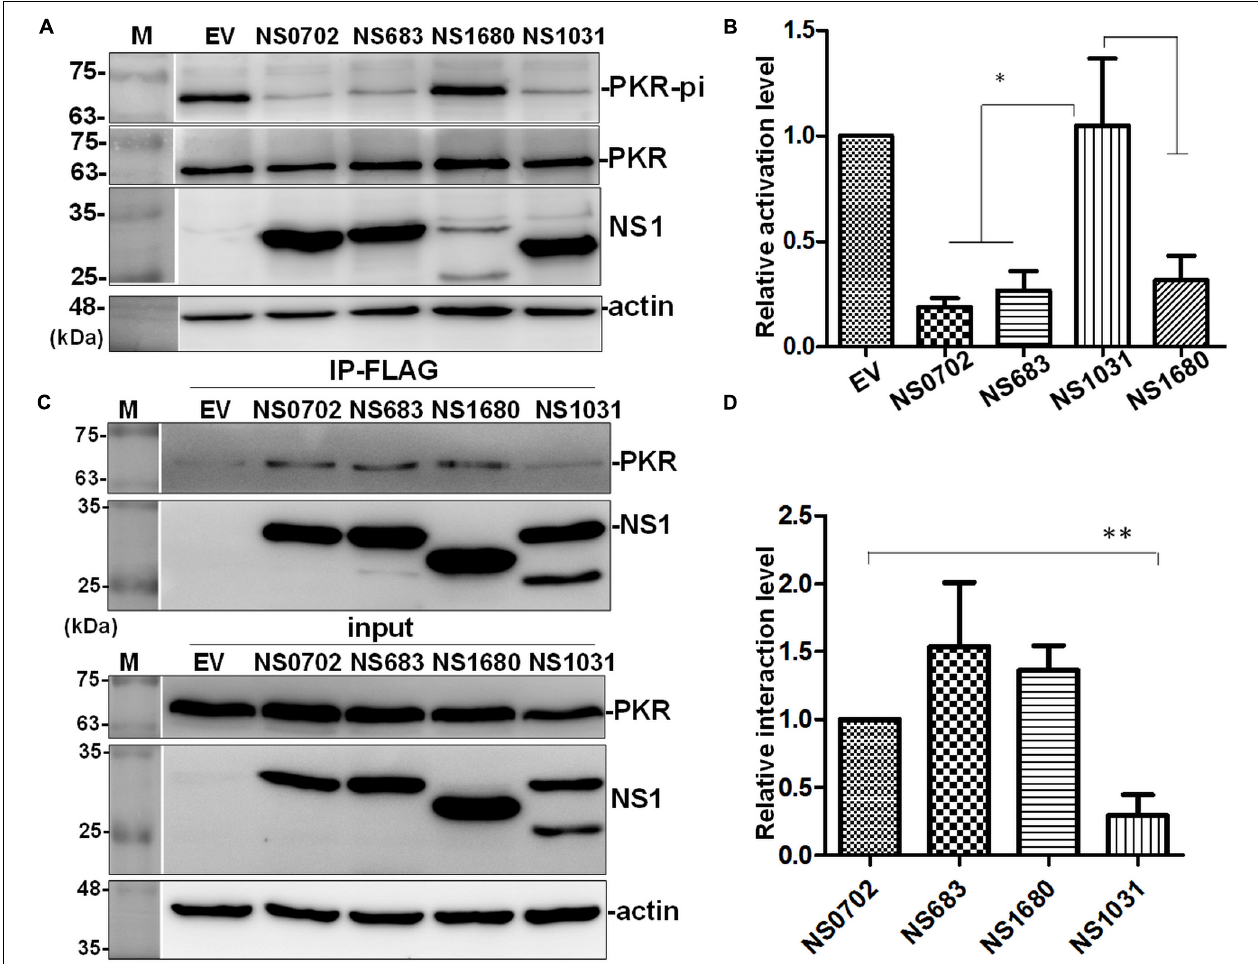
FIGURE 7 | The effect of avian influenza virus (AIV) non-structural protein 1 (NS1) proteins on protein kinase R (PKR) activation and interaction. (A,B) Modulation of PKR activation by NS1. HEK293T cells were transfected with empty vector (EV) or plasmids expressing NS1 proteins, followed by activation of PKR by the transfection of 150 ng/ml of poly I:C for 4 h. The phosphorylation level of PKR was monitored by (A) Western blot analysis; (B) PKR activation level was estimated relative to EV. (C,D) Interaction of NS1 proteins with PKR. (C) HEK293T cells were transfected with plasmids expressing hemagglutinin (HA)-tagged PKR together with either EV or one of the NS1 constructs, followed by FLAG-IP and immunoblotting. (D) Relative PKR–NS1 interaction was estimated relative to EV. All experiments were conducted in triplicate. ∗ and ∗∗ indicate p -value < 0.05 or < 0.001,